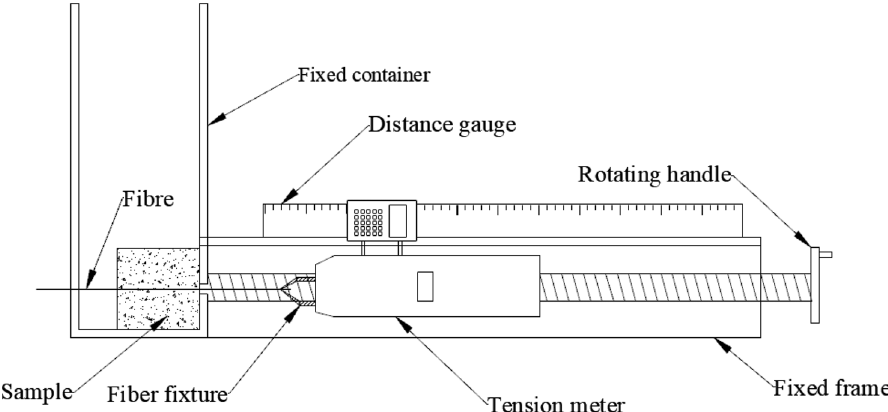
Figure 3. Single basalt fiber pullout apparatus (not to scale).